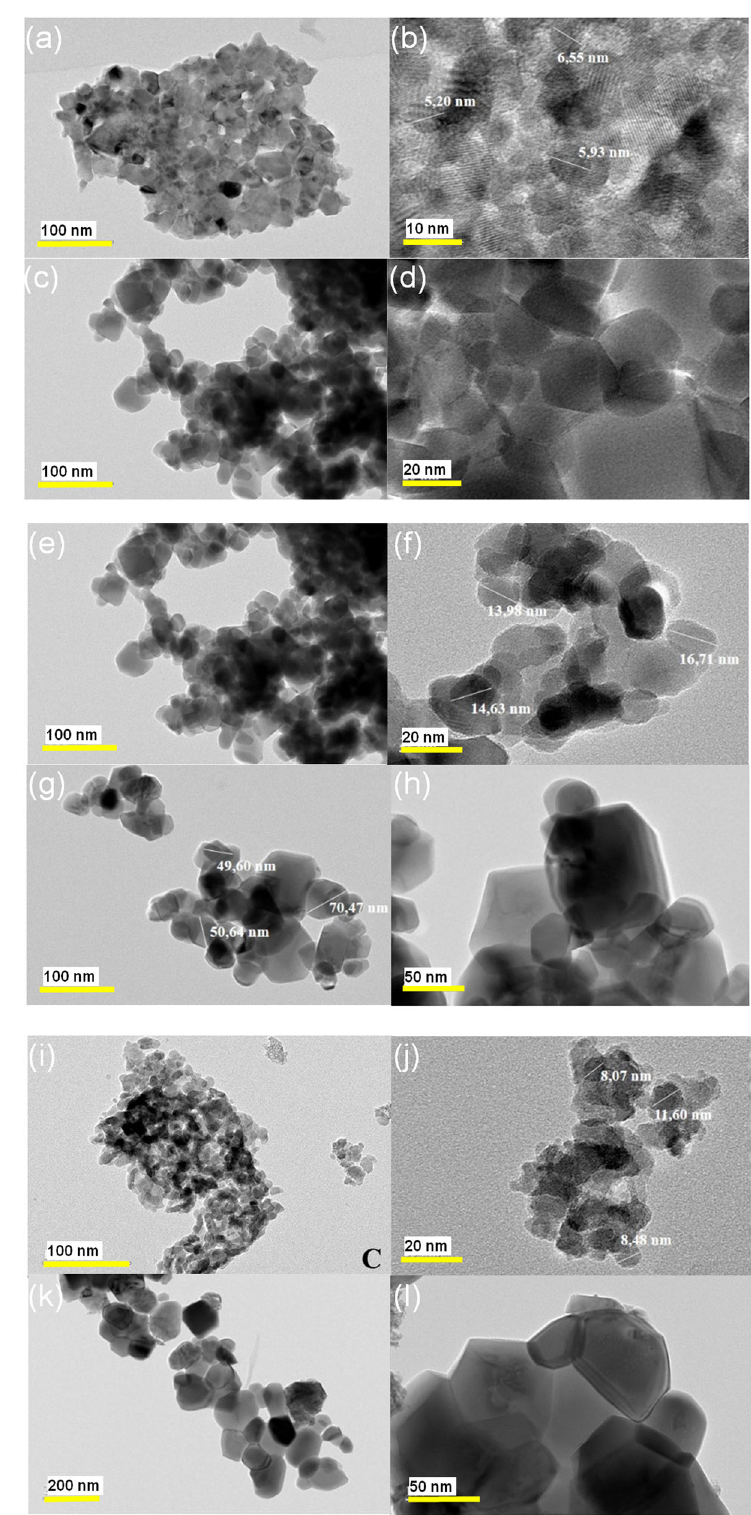
Fig. 5 TEM images for ZnFe 2 O 4 , CoFe 2 O 4 , and Zn 0.5 Co 0.5 Fe 2 O 4 NPs after calcination at 250 and 800 °C. ZnFe 2 O 4 NPs after calcination at a , b 250 °C and 800 °C c , d . CoFe 2 O 4 NPs after calcination at 250 °C ( e , f ) and 800 °C ( g , h ), and Zn 0.5 Co 0.5 Fe 2 O 4 NPs after calcination at ( i , j ) 250 °C and 800 °C ( k , l